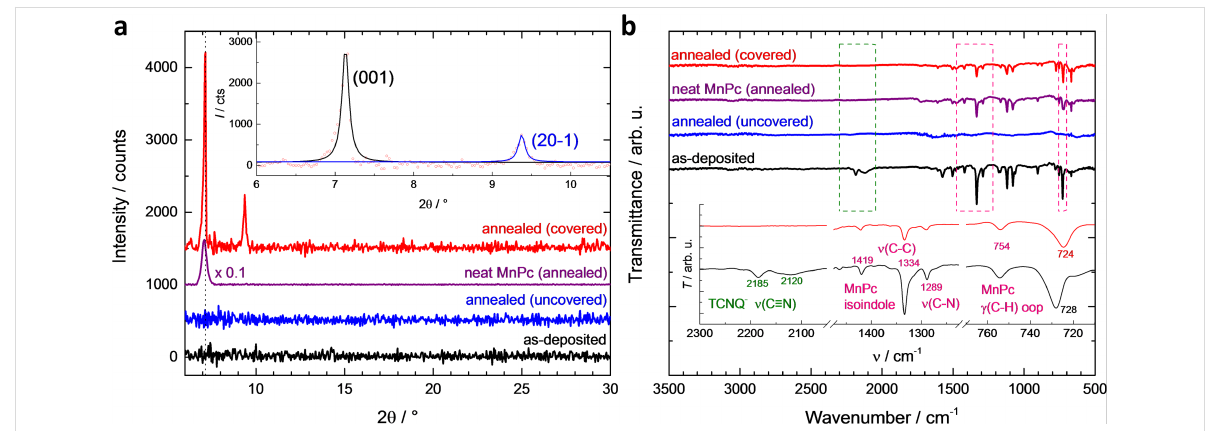
Figure 3: (a) X-ray diffraction patterns. For an as-deposited 144 nm thick MnPc:TCNQ film on silicon (black) no diffraction peaks are observed. Annealing without cover (blue) leads to similar results, whereas the covered film (red) exhibits two diffraction peaks with high intensity. For compari- son the XRD pattern of a neat MnPc film (purple) that was annealed at the same temperature is shown. All films were annealed at a temperature of 270 °C. (b) FTIR spectra for the same films deposited on KBr substrates. The green frame highlights the range of 2050–2300 cm − 1 where the ν (C ≡ N) stretching peaks for TCNQ appear. The pink frames show the area of the MnPc isoindole vibrations around 1225–1475 cm − 1 and the γ (C-H) out-of- plane deformation of the MnPc ligand at 710–770 cm − 1 , respectively. The inset shows specific regions in the mixed films (colour coding as in main graph).